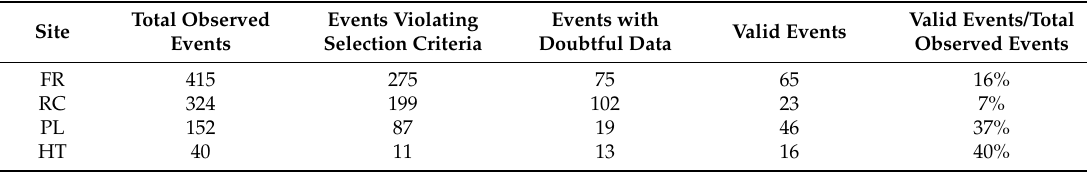
Table 4. Description of event database with continuous monitoring